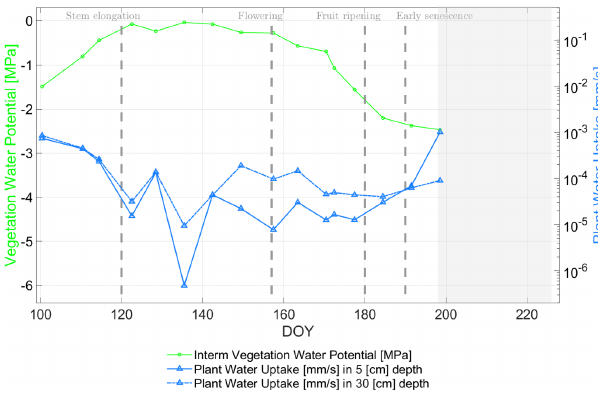
Figure 13. Comparison of radiometer-based plant water uptake PWU [mms − 1 ] (blueish curves with variable soil resistance at 5[cm] and 30[cm] soil depth) and vegetation water (solid green curve) potential VWP [MPa] along the growing season of 2017 for days of year (DOY) at the winter wheat field in Selhausen, Ger- many. The gray-masked area indicates the senescence phase where the water uptake estimates are no longer valid due to simplify- ing assumptions in the calculus of the root-xylem resistance. Ver- tical dashed lines indicate major phenological phases of the winter